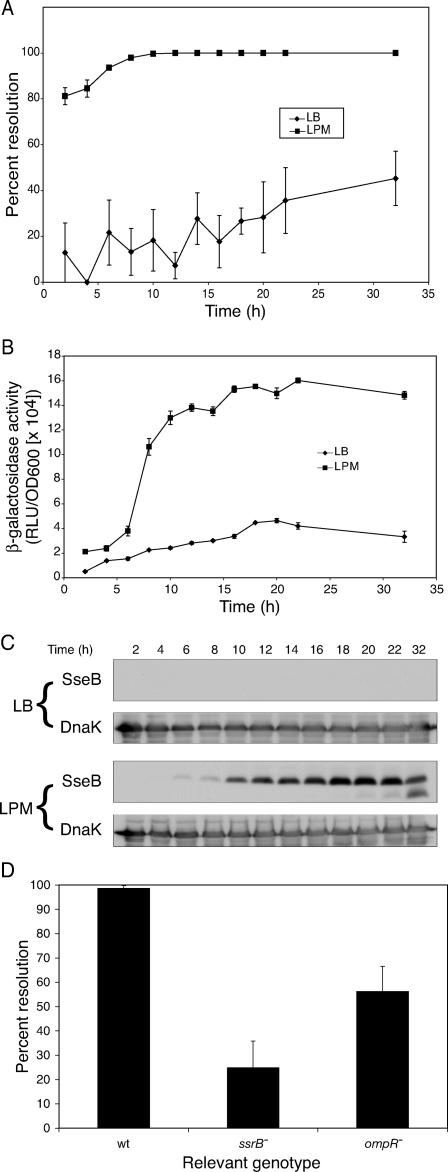
Expression from PsseA during Growth of Salmonella in Inducing and Non-Inducing Culture Media(A–C) The wild-type Salmonella RIVET strain (NB25) was inoculated into LPM (inducing) and LB (non-inducing) media at 1/100 of the culture volume, and cultures were incubated with shaking at 37 °C. At the indicated time points, samples were taken for measurement of culture OD600 (unpublished data), colony-forming units per millilitre (unpublished data), β-galactosidase activity, percent resolution, and native SseB levels. The results shown for percent resolution (A) and β-galactosidase activity (B) are the mean ± standard error of the mean from three independent experiments. The levels of SseB associated with bacteria were detected by immunoblotting (C). Protein loading was normalized to culture OD600 and was confirmed by immunoblotting for the abundantly expressed cytoplasmic protein DnaK.(D) Wild-type (NB25), ssrB
− (NB7), and ompR
− (NB15) were grown in LPM medium and percent resolution was determined from the cultures at 10 h.